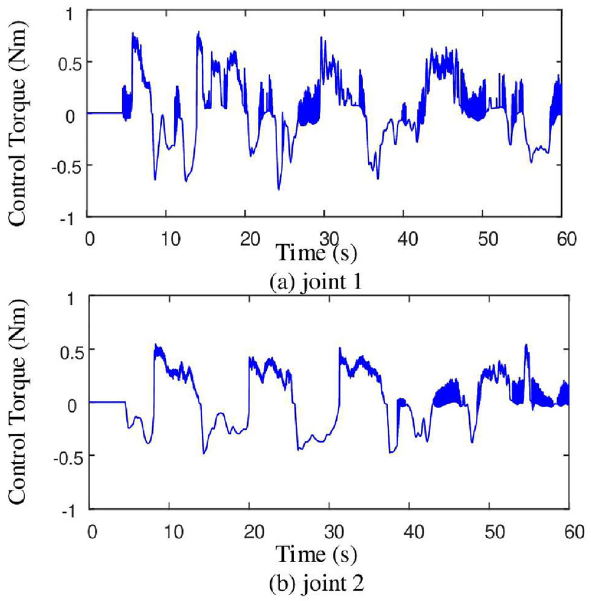
Fig. 11 Joint position tracking curves under proposed decentralized robust interaction control method